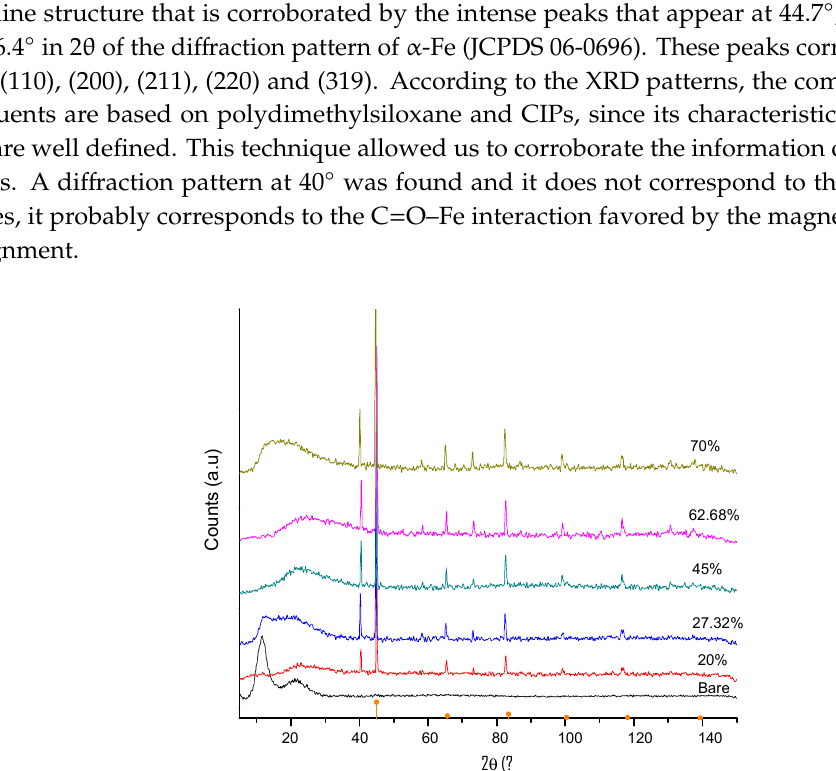
Figure 11. Diffraction pattern (JCPDS 06-0696) of the composite material samples made for the CIPs concentrations of 20, 27, 45, 63 and 70 wt %.